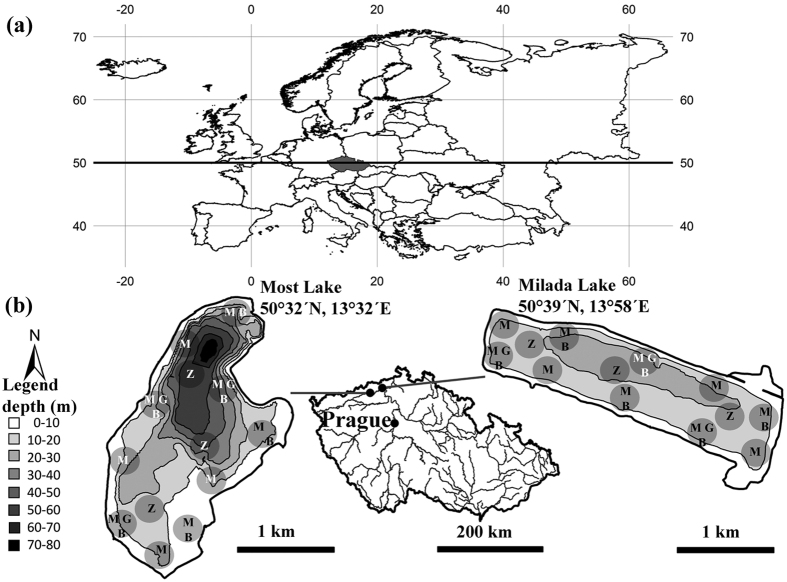
A map showing (a) the location of the Czech Republic within Europe (latitude of 50° north as bold line) and (b) the location of the two study sites, Milada and Most Lakes, in the Czech Republic. A detailed view of the bathymetric maps shows contour lines with relevant depths and sampling localities: B = benthic invertebrates sampling; G = gillnets sampling; M = macrophytes sampling; Z = zooplankton sampling. The figure was generated by the software ArcMap, version 10.2.259.